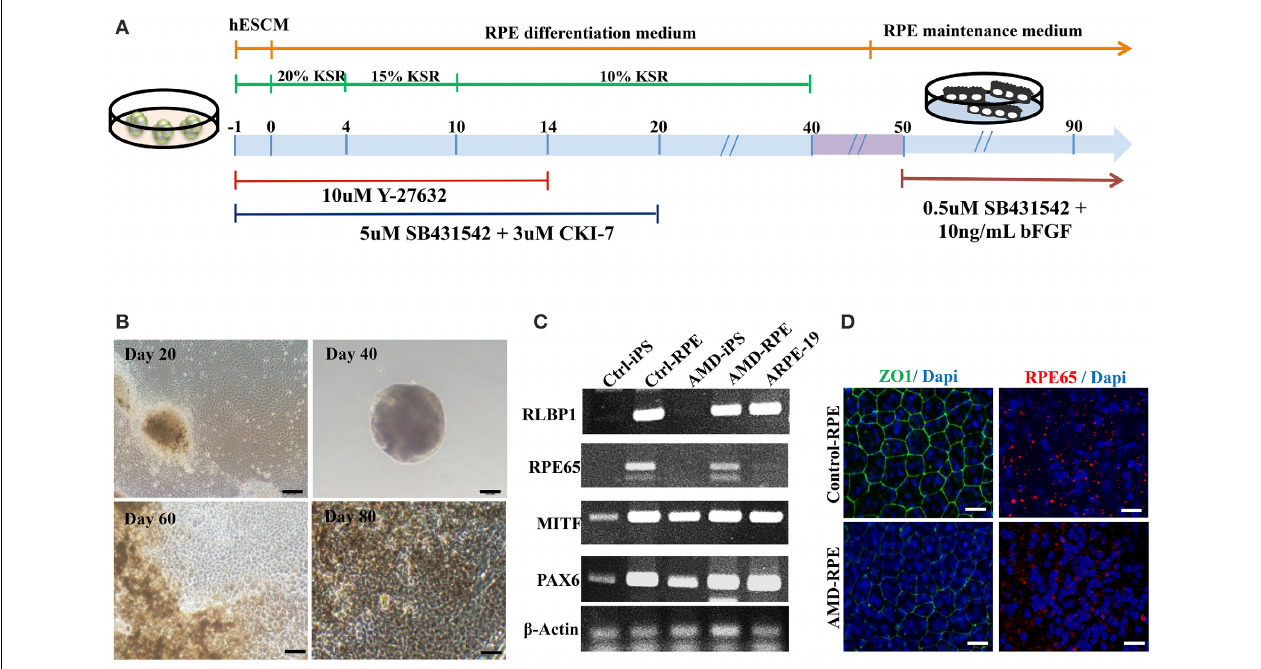
FIGURE 3 | Differentiation of induced pluripotent stem cells into retinal pigment epithelial cells. (A) Schematic diagram of the culture procedure for RPE differentiation. (B) Light microscopic images of RPE cells derived from control and AMD iPSCs confirmed characteristic RPE morphology and